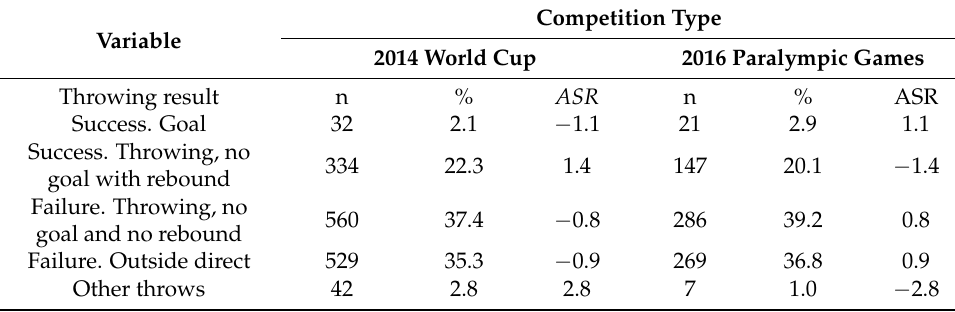
Table 5. Descriptive results and ASRs of the efficiency